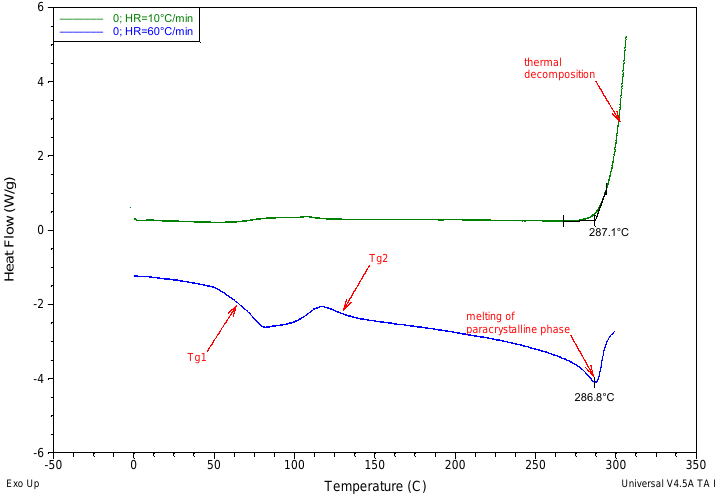
Figure 11. DSC curves for samples of unmodified PAN membrane (0) registered in the heating mode in nitrogen atmosphere with the rate of: 10°/min (green) and 60°/min (blue), respectively.